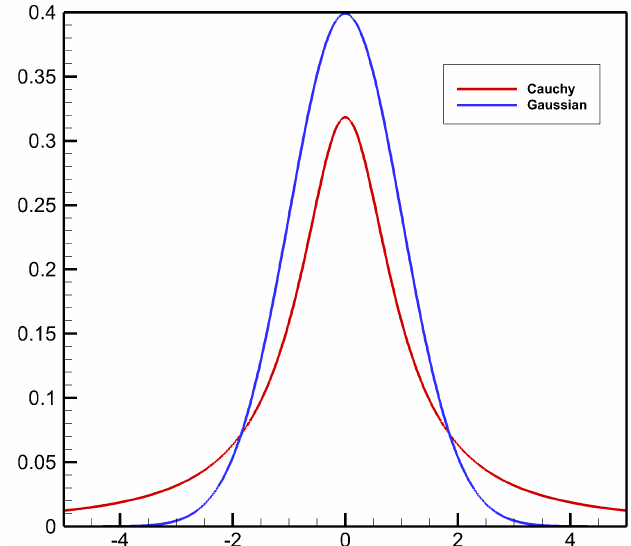
Figure 5. Probability density functions of the Cauchy and Gaussian